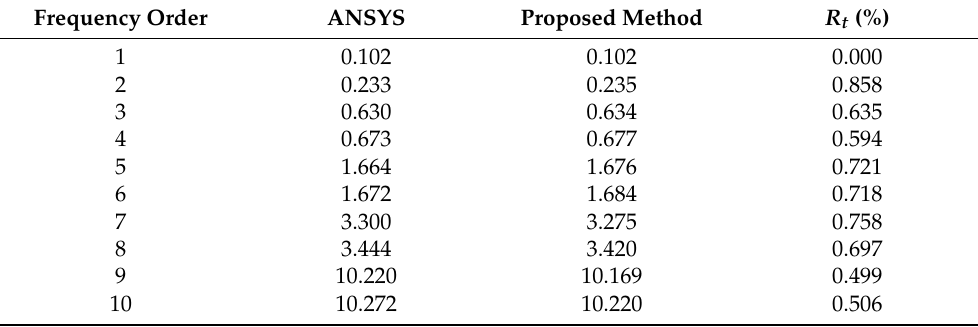
Table 1. Comparison of the fi rst twelve frequencies of the system, f (Hz).